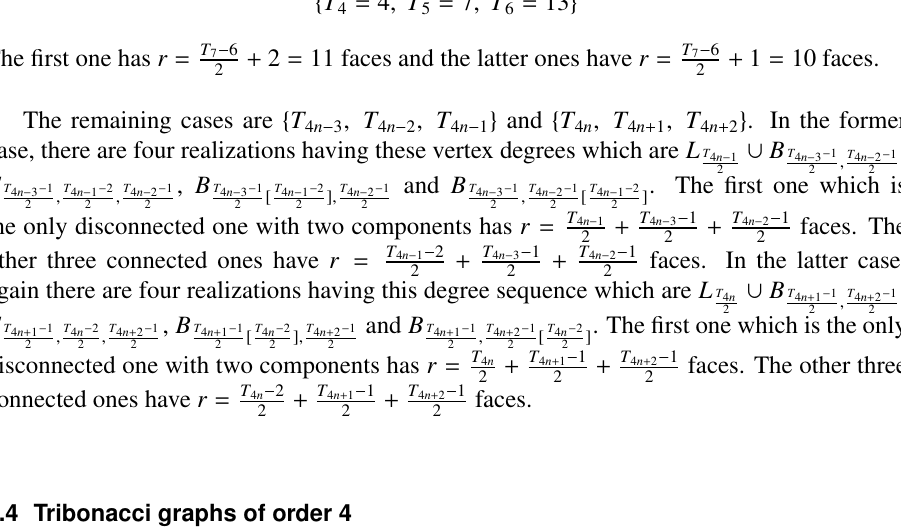
{ T = 4 , T = 7 , T = 13 4 5 6